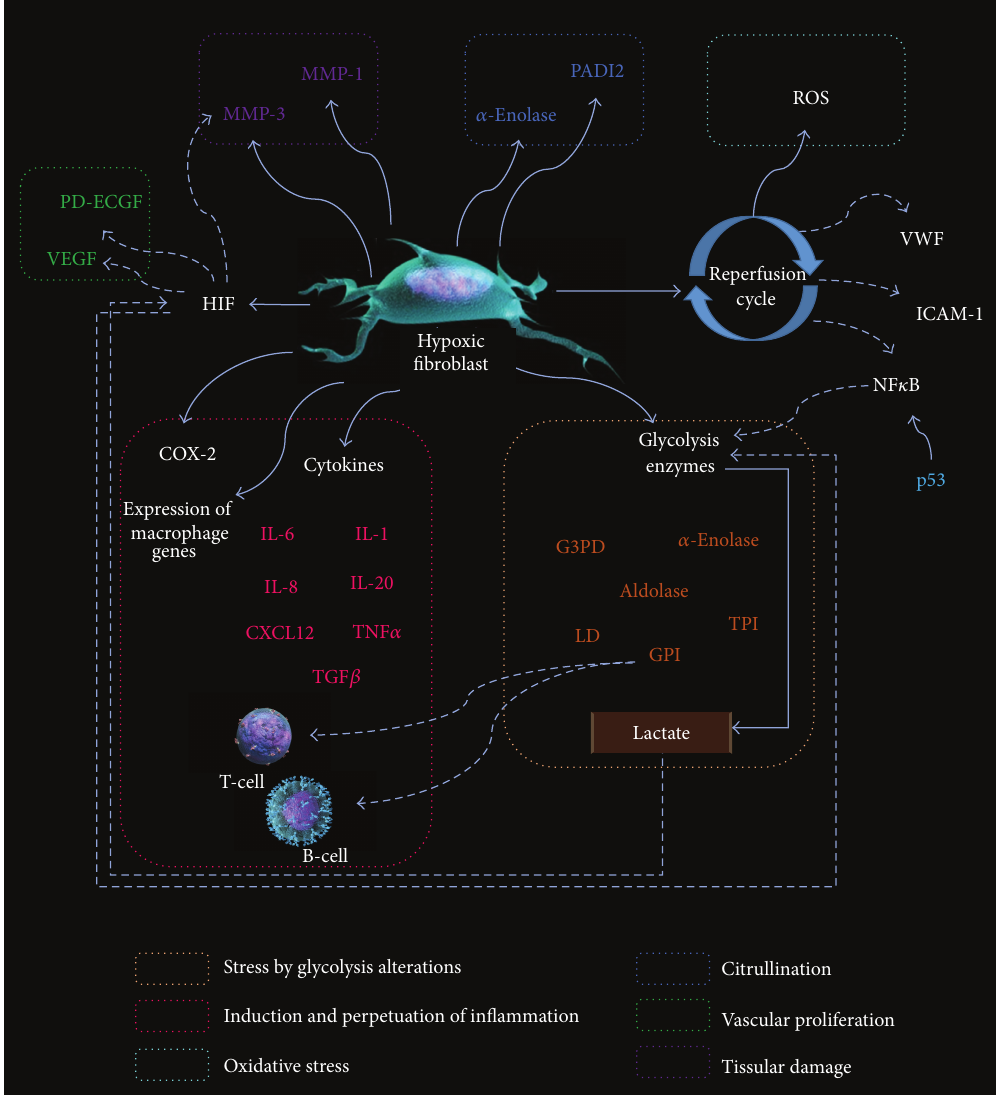
Figure 3: The hypoxic impaired fibroblast in RA. The hypoxia in the rheumatoid synovium induces several phenotypic changes in the fibroblasts; it not only enhances the synthesis of proinflammatory cytokines and metalloproteases, but also induces the glycolysis pathways upregulating the enzymes, which become antigenic because they are abundant in a stressed scenario and eventually are presented by the local